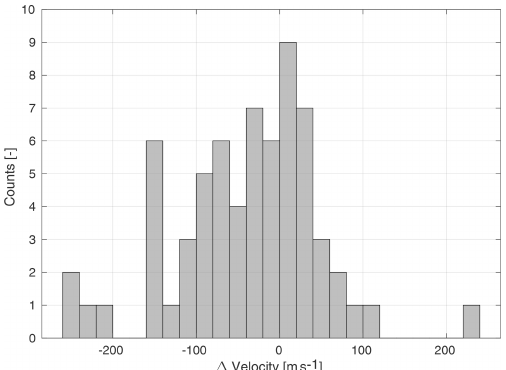
Figure 14. Histogram of the misfit between the Deltares-NAM ve- locity model (Kruiver et al., 2017) and the velocity profiles for the lower part of the North Sea Group ( V NSL s ) presented in this paper. A count with a positive misfit corresponds to a station location with higher velocities in the Deltares-NAM